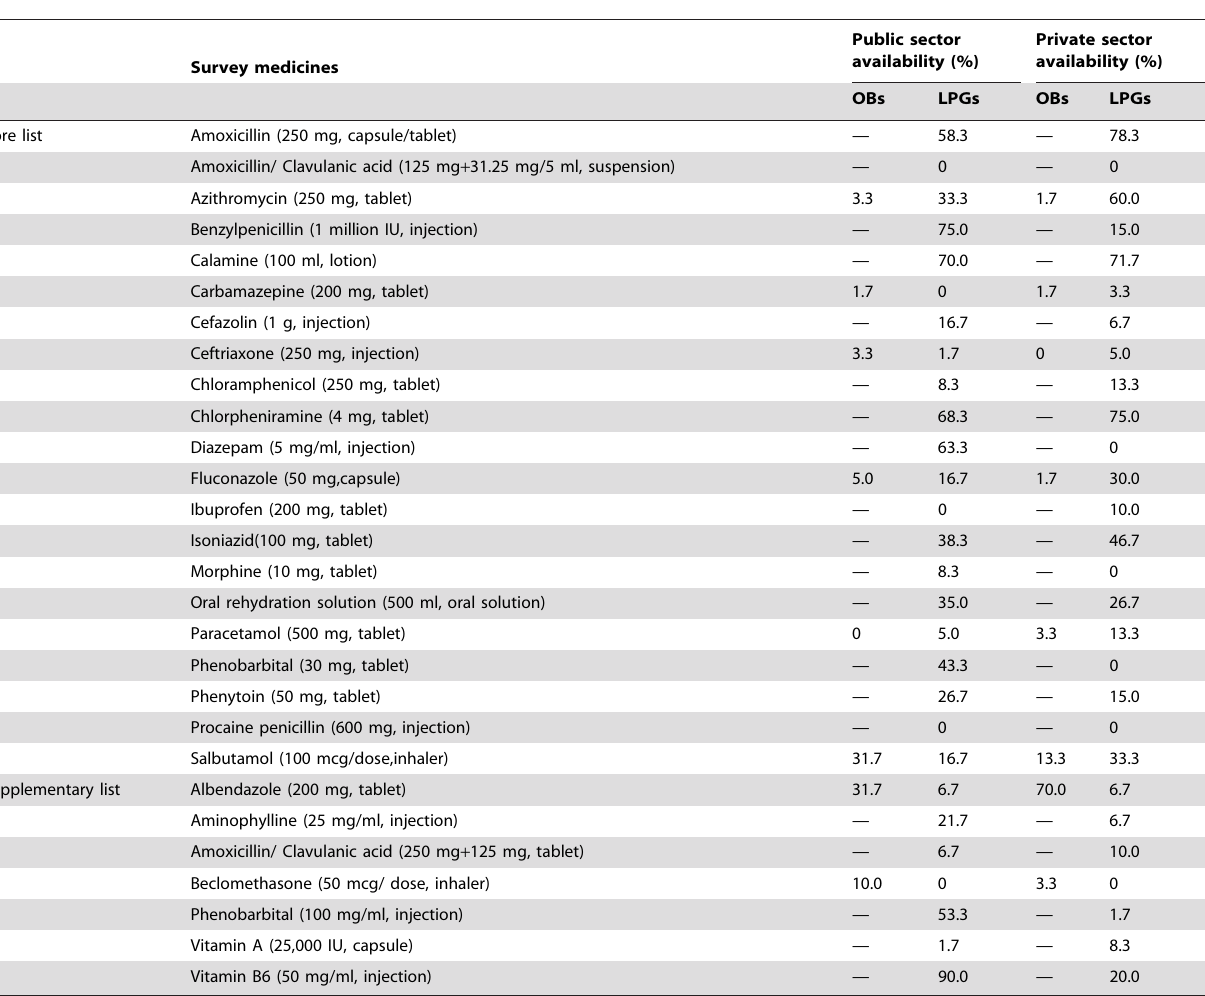
Table 1. Availability of medicines in the public sectors and the private